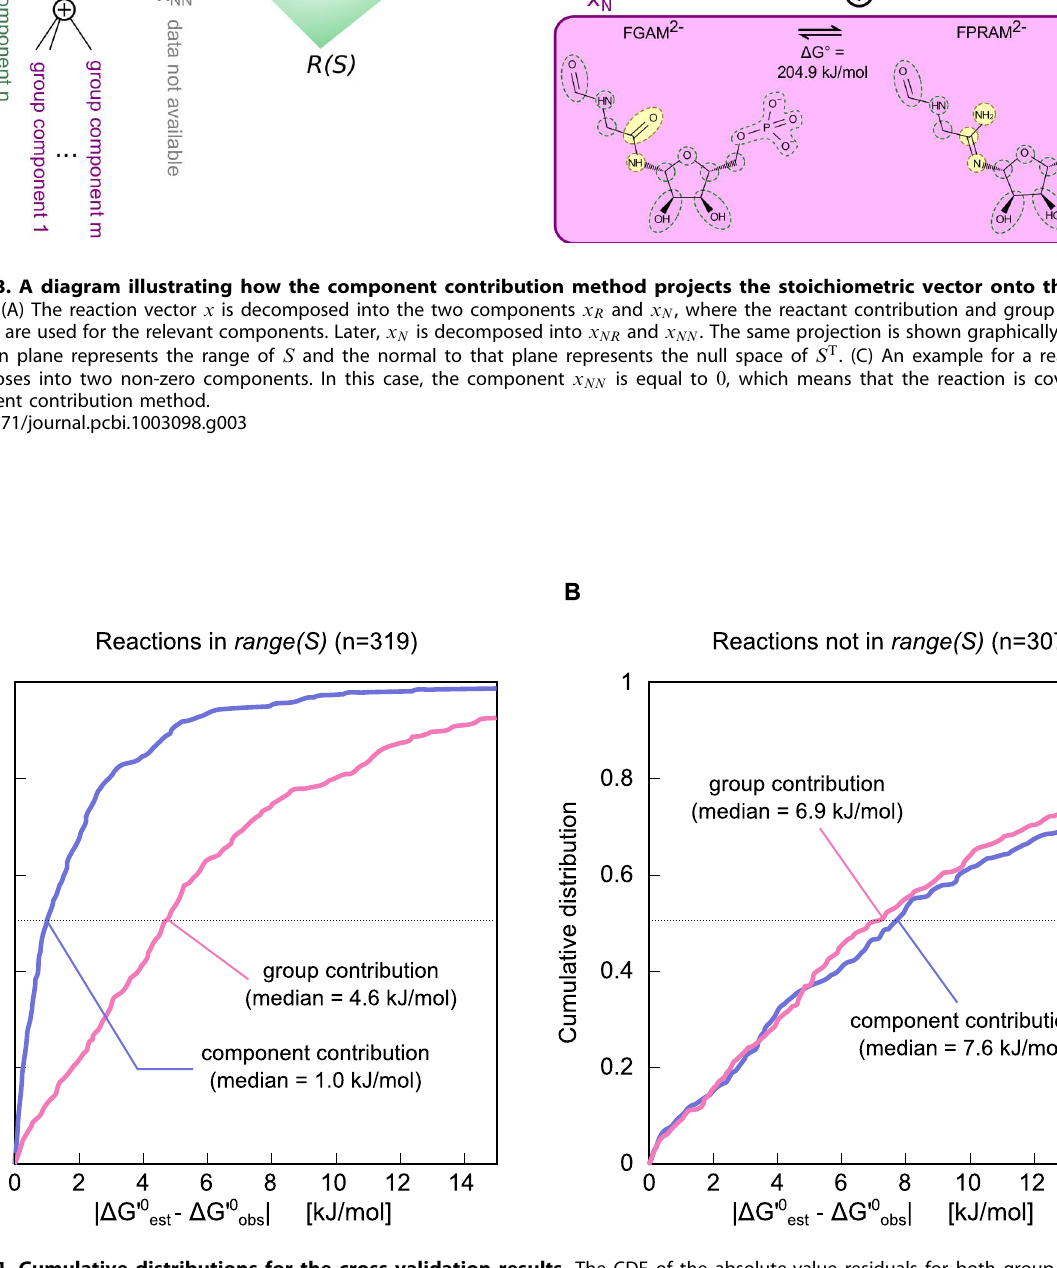
Figure 4. Cumulative distributions for the cross-validation results. The CDF of the absolute-value residuals for both group contribution ( DD e rc DD , pink) and component contribution ( DD e cc DD , purple). The reactions were separated to ones which are (A) linearly-dependent on the set of all other reactions ( s j is in the range of S ( j ) , the stoichiometric matrix of all reactions except s j ), and (B) to ones which are linearly-independent (and thus component contribution uses group decompositions for at least part of the reaction). We found an 80% reduction in the median for the former set and no significant change for the latter (p-value= 0 : 45 ).